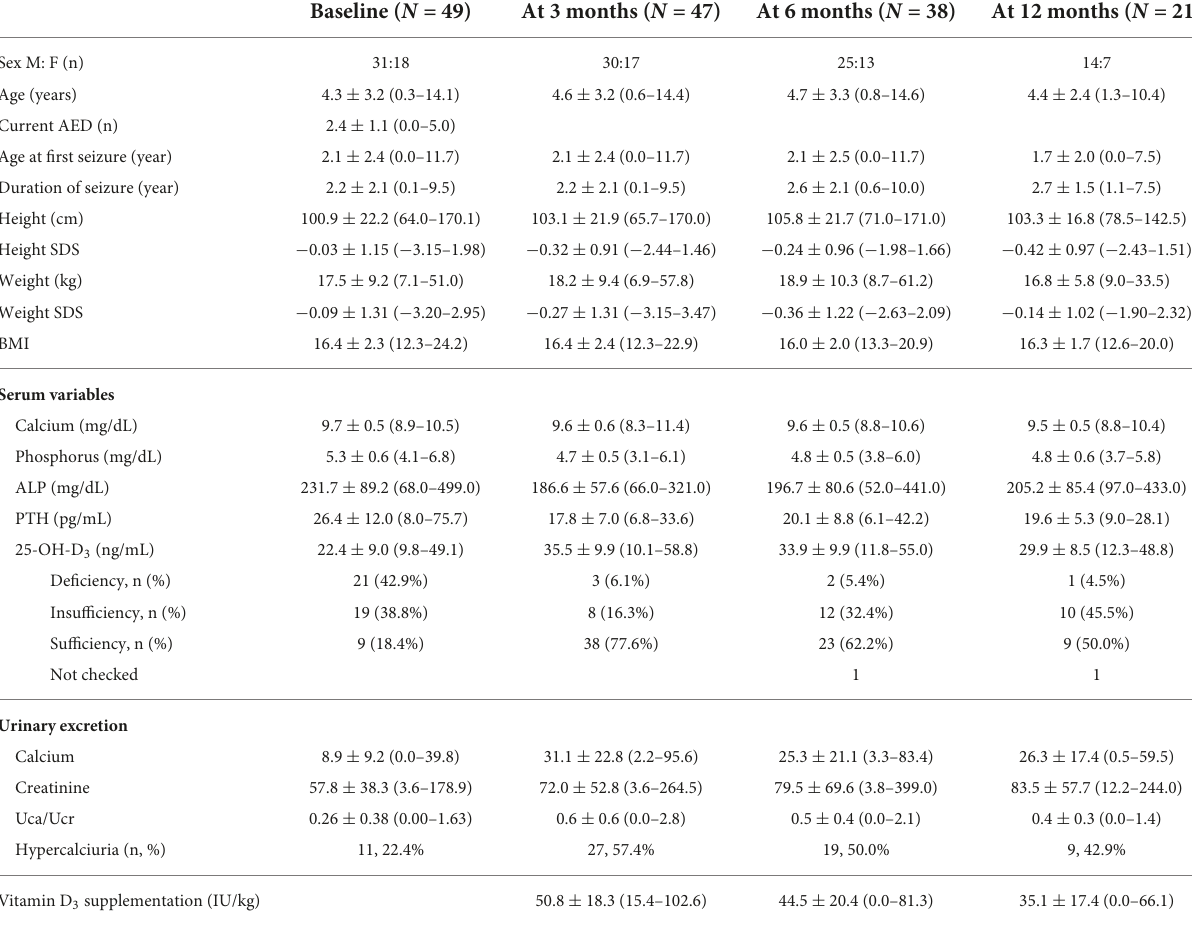
TABLE 1 Characteristics of children with intractable epilepsy at ketogenic dietary therapy initiation.